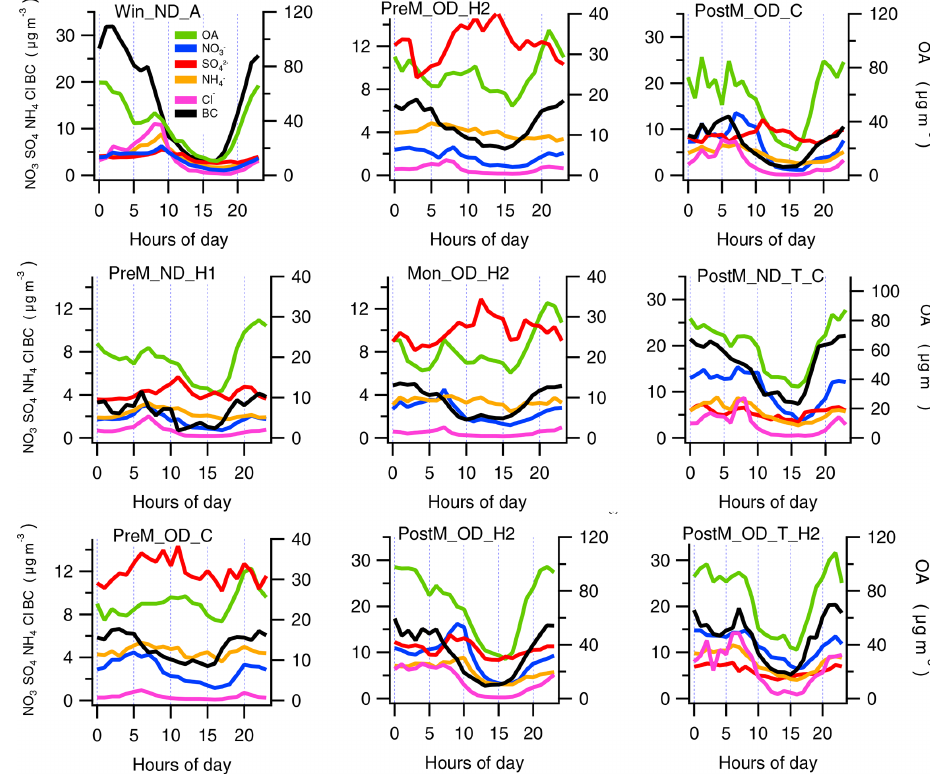
Figure 3. Median diurnal concentrations of the aerosol chemical